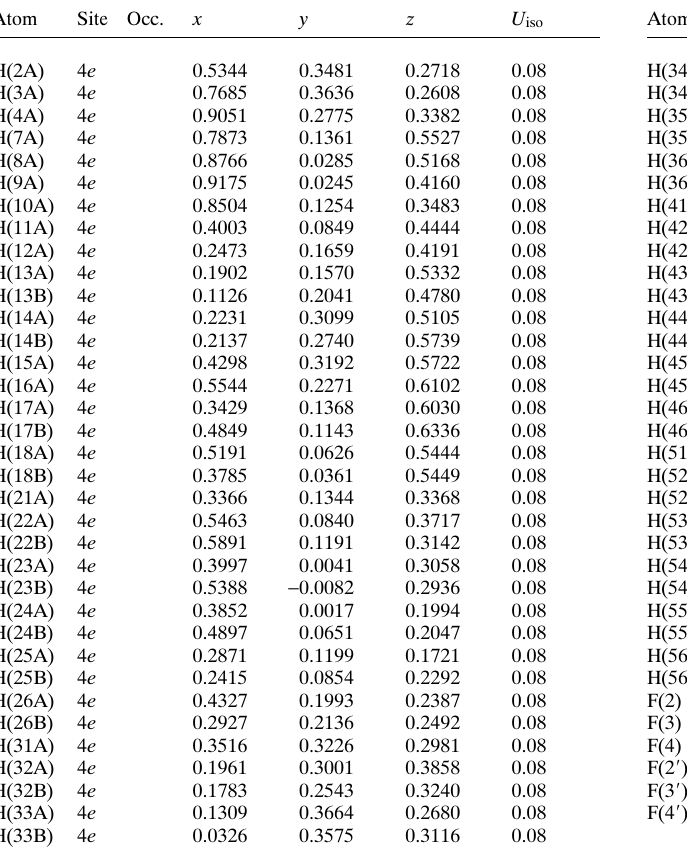
Table 5. Atomic coordinates and displacement parameters (in Å 2 ) .